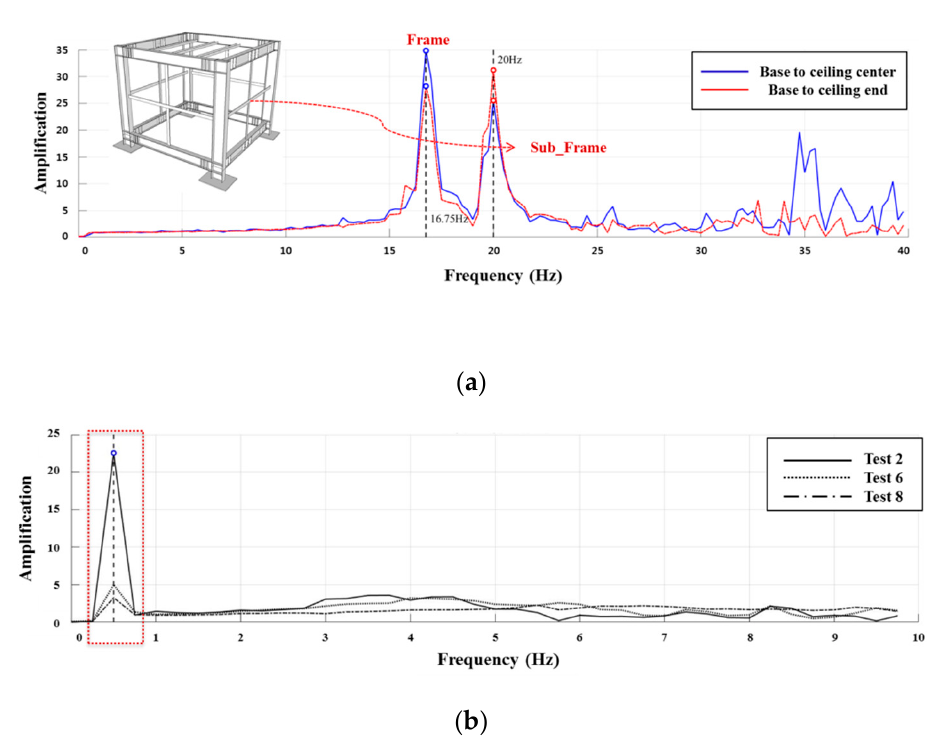
Figure 13. Natural frequency confirmed by the transfer function, Un-Seismic Designed ceiling (USD). ( a ) Transfer function (base to ceiling) and ( b ) the natural frequency estimated by using the transfer function below a frequency of 10 Hz.